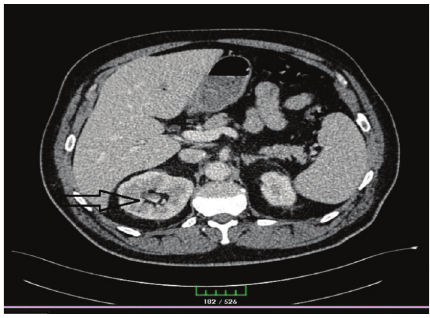
Figure 2: CT image showing hydronephrosis in the right